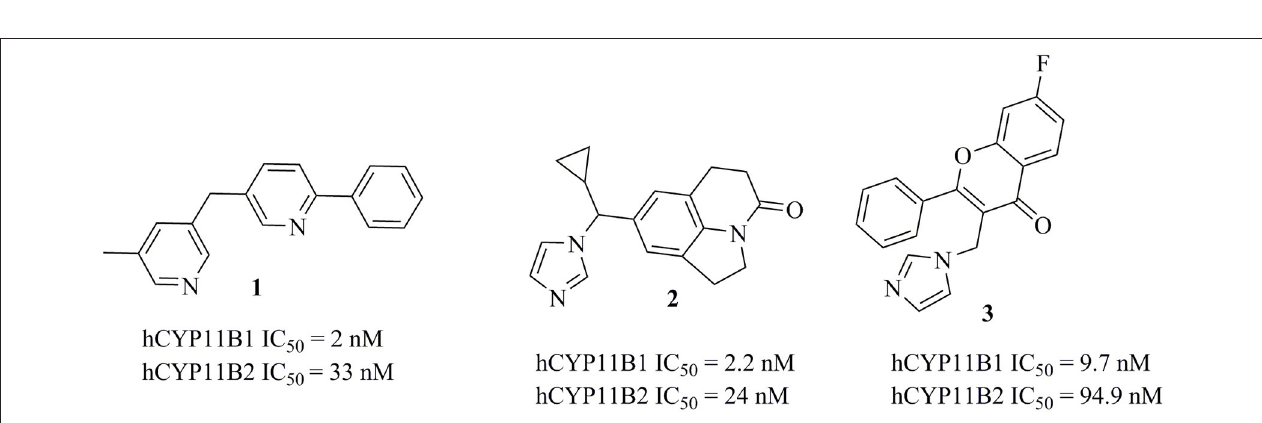
FIGURE 2 | Structures of previously published CYP11B1 and CYP11B2 inhibitors (Yin et al., 2012; Emmerich et al., 2013; Gobbi et al., 2016).